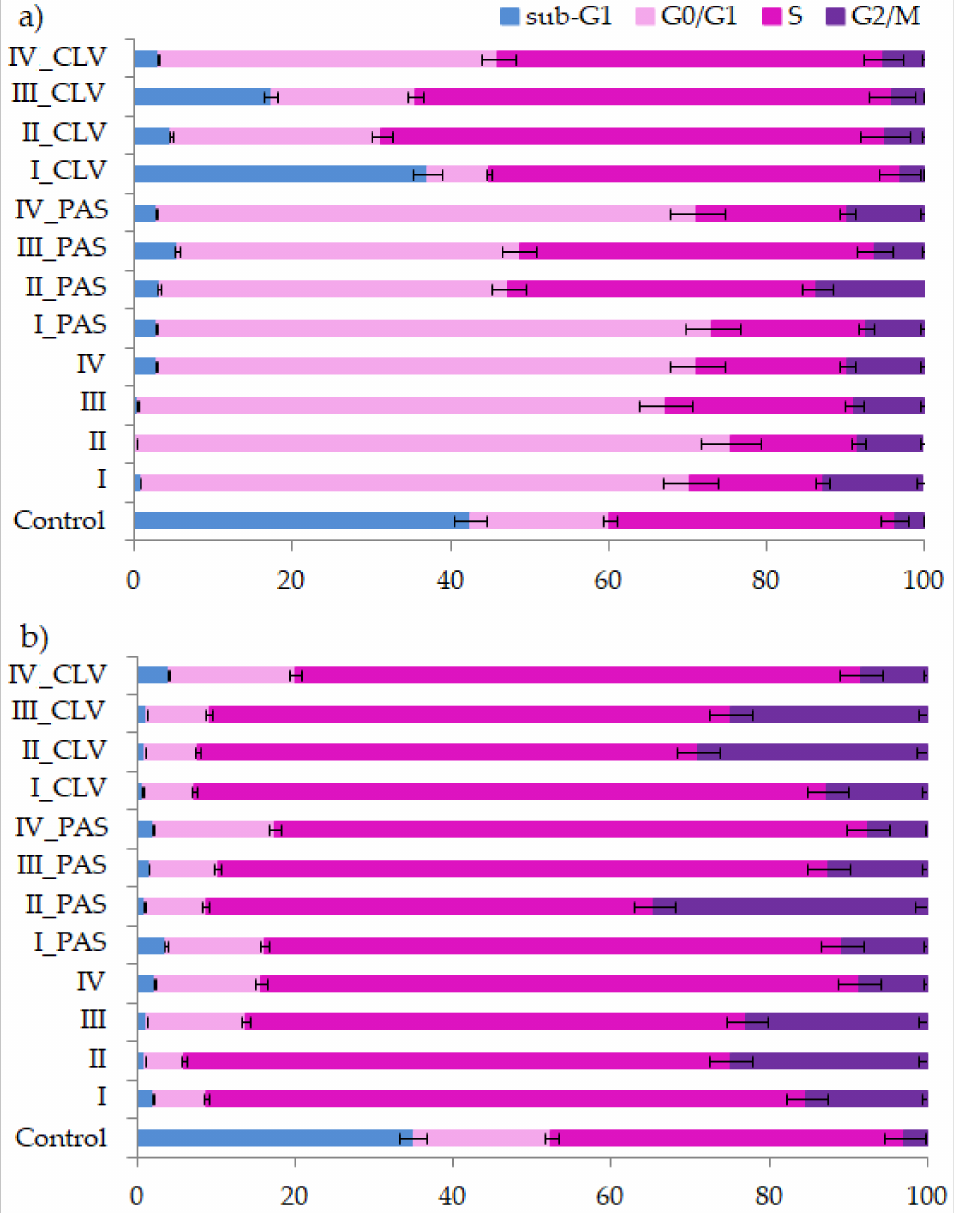
Figure 7. Cell cycle analysis of ( a ) A549 and ( b ) BEAS-2B cell lines treated by carriers I–IV or conjugates with PAS and